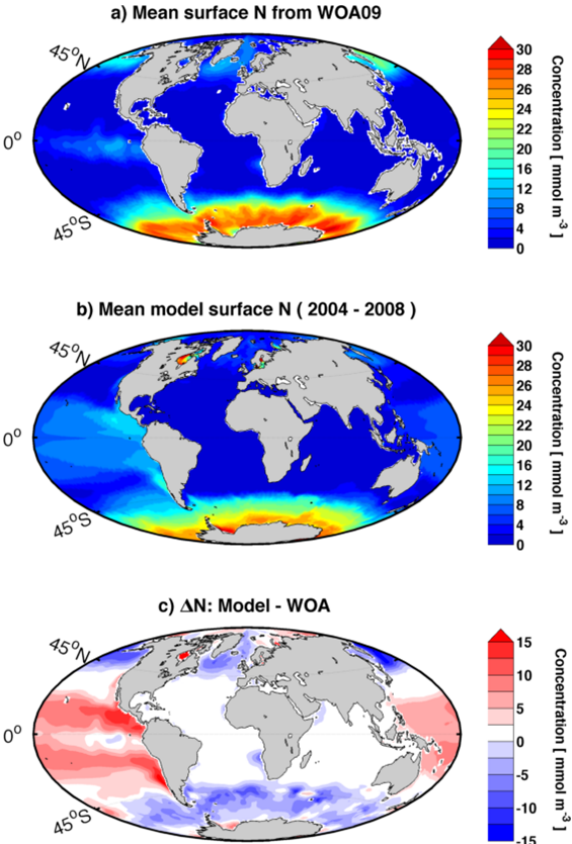
Figure 7. Spatial distribution of mean surface concentration of dissolved inorganic nitrogen. (a) Observed (Garcia et al., 2010) (b) Modelled. (c) Residual: modelled − observed.